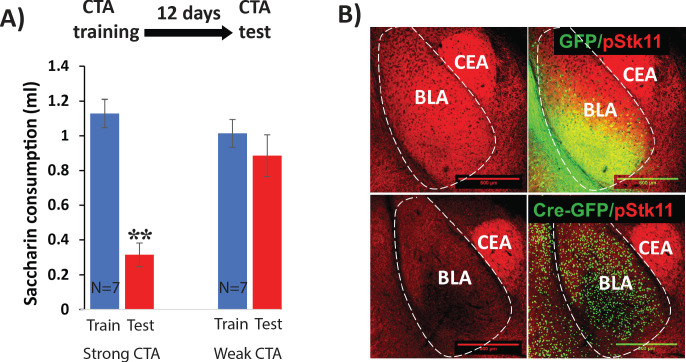
Controls for Stk11 deletion experiments.(A) CTA elicited by a dose of 0.15 M LiCl 1% body weight (Weak CTA) does not last 12 days following training (N = 7, t(12)=0.9, p=0.39). On the other hand, CTA elicited by a LiCl dose of 0.15M 2% body weight (Strong CTA) does (N = 7, t(12)=7.8; p=5×10−06). (B) Conditional knock-out of Stk11 reduces phospho-STK11 protein expression. Immunostaining for STK11 protein (phosphorylated at serine 431) was performed 10 days after BLA infection with Cre or control viruses. Scale bar: 500 µm.